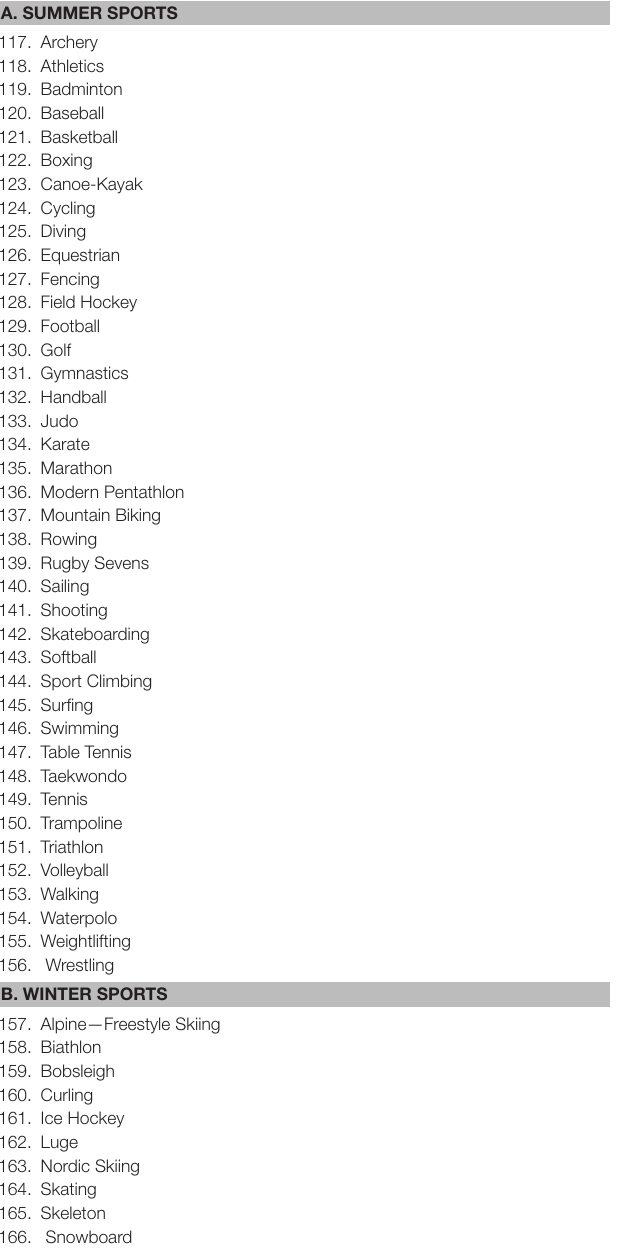
TABLE 2 | Summer (A) and Winter (B) Olympic sports (https://olympics.com/en/